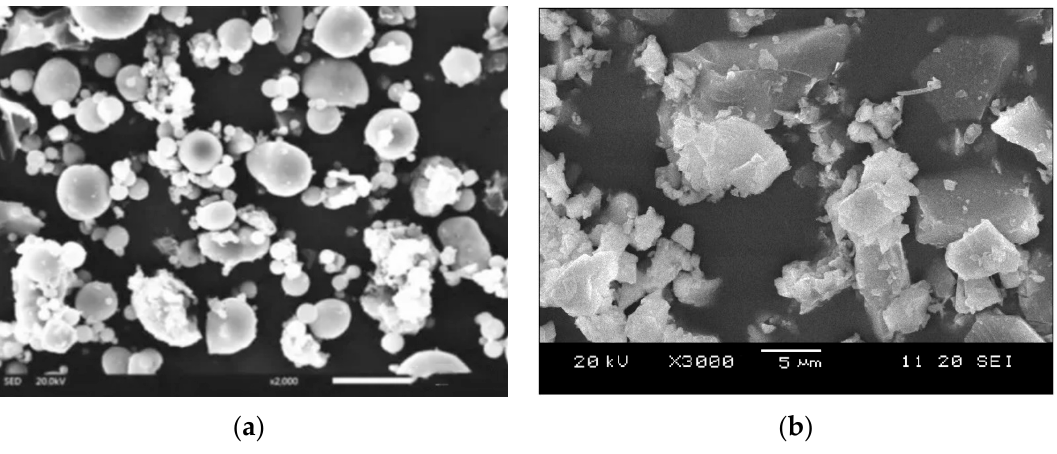
Figure 1. SEM graph of SCMs: ( a ) fly ash; ( b )